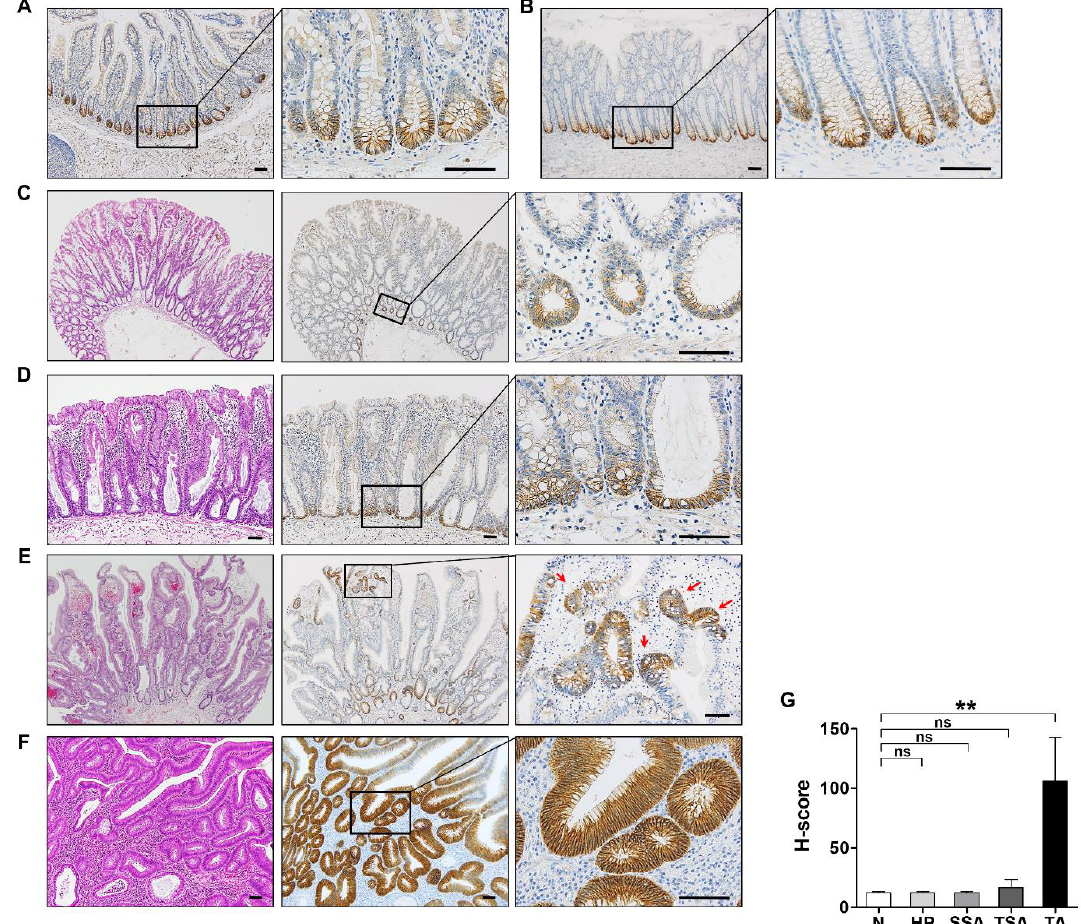
Figure 2. Distinct EPHB3 expression patterns in colorectal precancerous lesions. Representative images of EPHB3 expression in normal small ( A ) ( n = 1) and large ( B ) ( n = 5) intestinal mucosa, hyperplastic polyp (HP, n = 5) ( C ), sessile serrated adenoma (SSA, n = 5) ( D ), traditional serrated adenoma (TSA, n = 3) ( E ), and conventional tubular adenoma (TA, n = 5) ( F ). ( G ) Histo-scores of EPHB3 in each lesion. Data are presented as the mean ± SEM. SEM: standard error of the mean. ns, not significant. ** p < 0.01. Scale bars: 50 µ